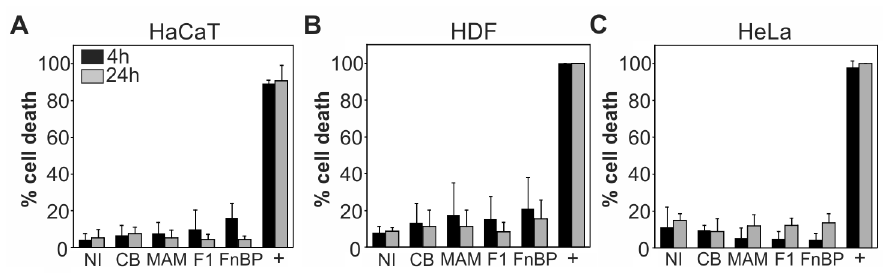
Figure 4. Adhesion inhibitors do not affect host cell survival. Cell death of HaCaT (A), HDF (B) or HeLa cells (C) was measured using lactate dehydrogenase release assays following 4 hours (black) or 24 hours (gray) of incubation in growth medium alone (NI) or medium containing 500 nM immobilized GST (CB), MAM7, F1 or FnBPA peptide, or 1μM staurosporine (+ control). Results are means ± standard deviation from one of a set of three experiments done in triplicate. According to student t-test, p<0.01 for all samples compared to positive control.